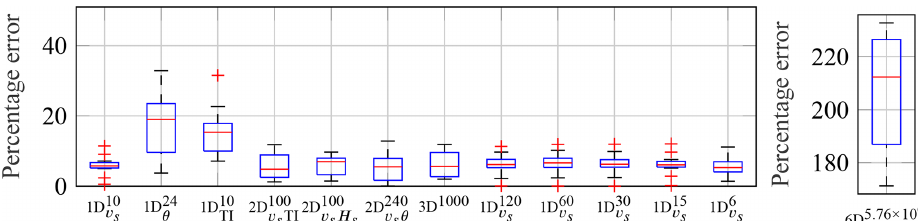
Figure 14. Percentage errors of predicted yearly damage values using a binning method compared to real yearly damage values. Comparison of various bin types and sizes ( n is the overall number of bins): wind speed ( v s ), wind direction ( θ ) and turbulence intensity (TI) only (1D n x ); combinations of two environmental conditions out of wave height ( H s ), v s , θ and TI (2D n xy ); v s , TI and H s (3D); and all six environmental conditions (6D). Please note: for the sake of clarity, the vertical axis is scaled differently for 6D.